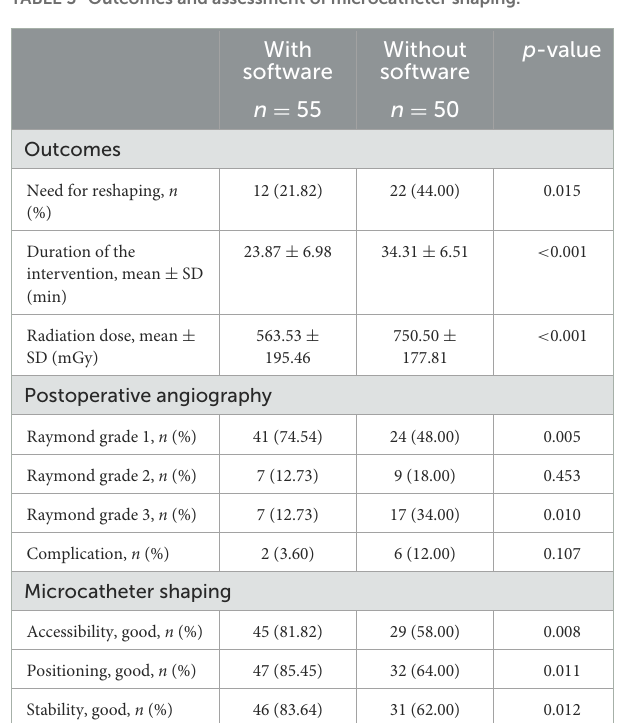
TABLE 3 Outcomes and assessment of microcatheter